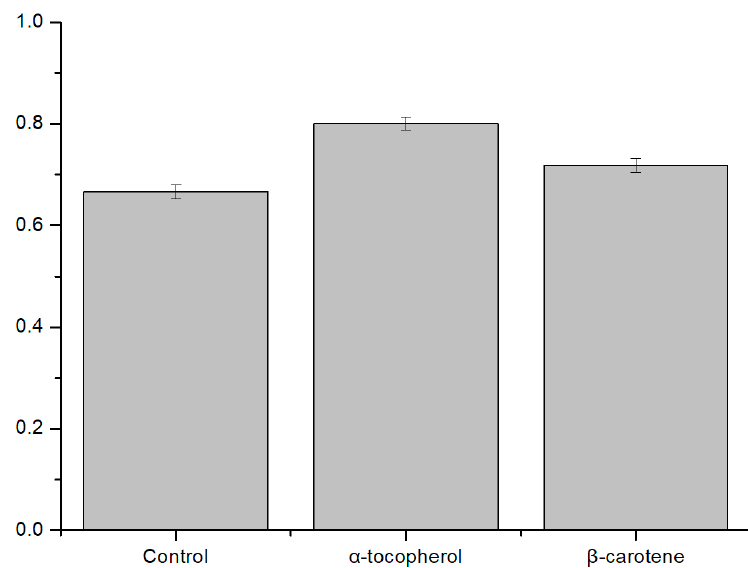
Figure 5. Comparison of the activities of two types of fat-soluble antioxidants. α -tocopherol and β -carotene were used at a molar ratio of 0.05% of the total concentration. The ratio of the fluorescence intensity difference was analyzed (after light illumination/before light illumination) (N = 8). The smaller the value is, the more unstable it is. The control was an asymmetric liposome. α -tocopherol has a greater ROS scavenging effect than β -carotene (Table